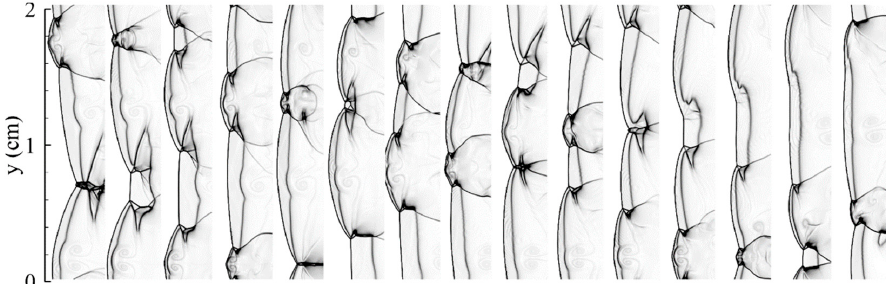
Figure 13. Cell bifurcation resulting from the micro explosion of the unburnt pocket of fuels.